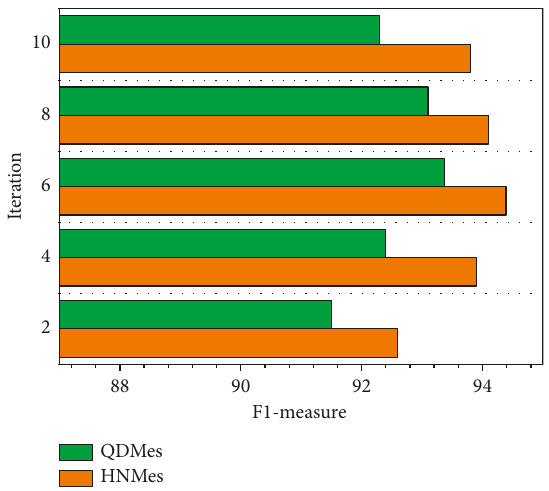
Figure 7: Influence of iterations on the experimental results. Table 4: Description of English datasets.